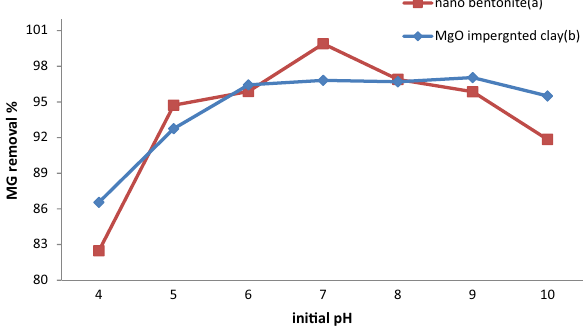
Figure 6. Effect of pH on MG dye removal by ( a ) nano bentonite and ( b ) MgO impregnated clay.